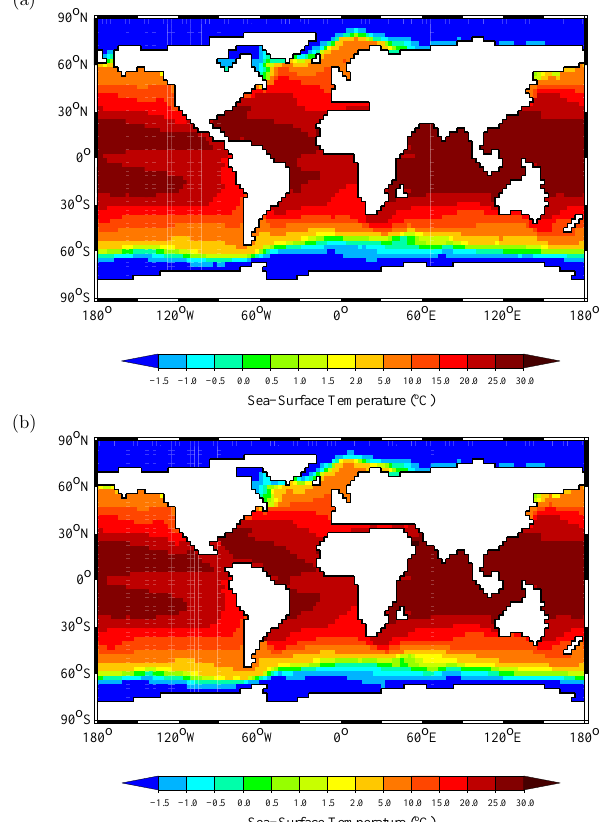
Fig. 1. Initial sea-surface temperatures for (a) the CTRL experiment and (b) the Miocene experiments. Grid elements with a temperature below − 1.5 ◦ C are covered by